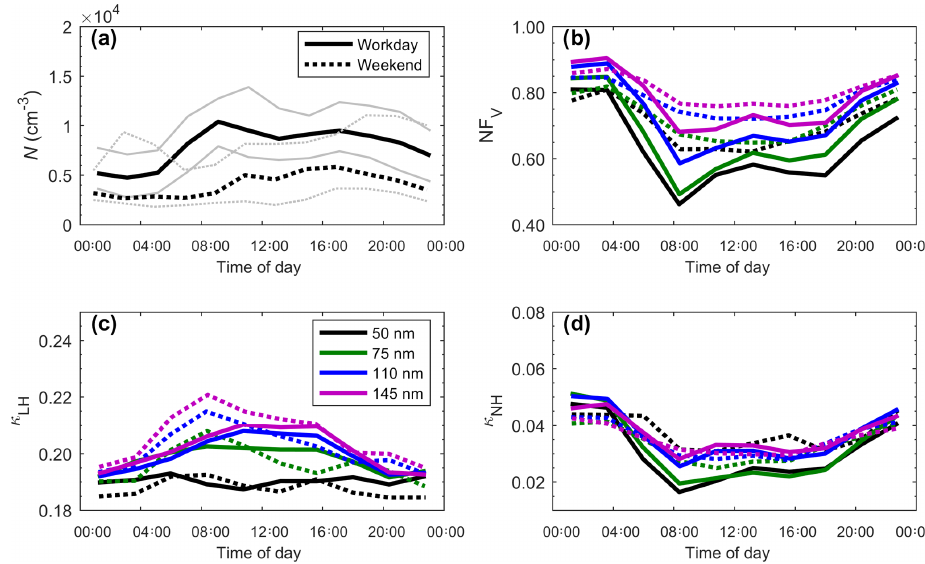
Figure 6. Diurnal variation of the median total particle number concentration ( N ; a ), and the mean particle number fraction of volatile particles (NF V ; b ), the mean hygroscopicity parameter of the less hygroscopic mode ( κ LH ; c ) and nearly hydrophobic mode ( κ NH ; d ) separately for workdays (solid lines) and weekends (dotted lines) for different dry particle diameters. The thin lines in grey in (a) represent the lower and upper quartiles of the corresponding concentration data. (b) , (c) and (d) have shared